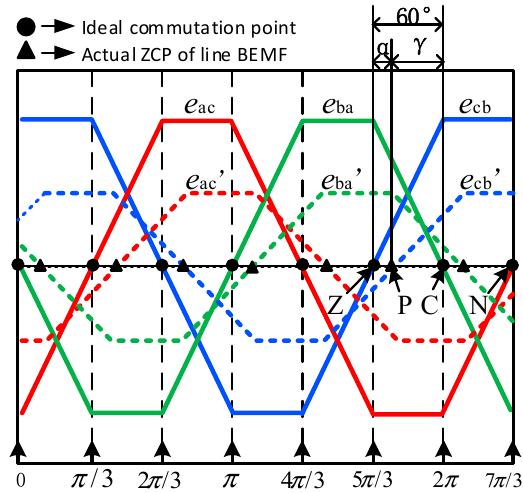
Figure 5. Scheme of 60°- α mode. ZCP: zero-crossing point.